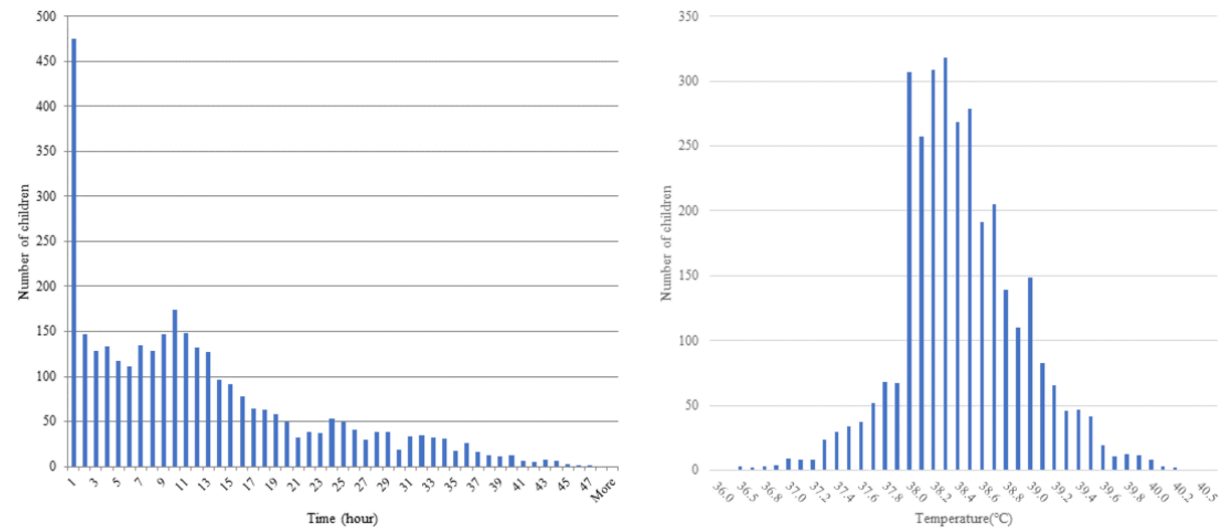
Figure 4. Time of first administration of antipyretic after vaccination and body temperature at the time of antipyretic use.